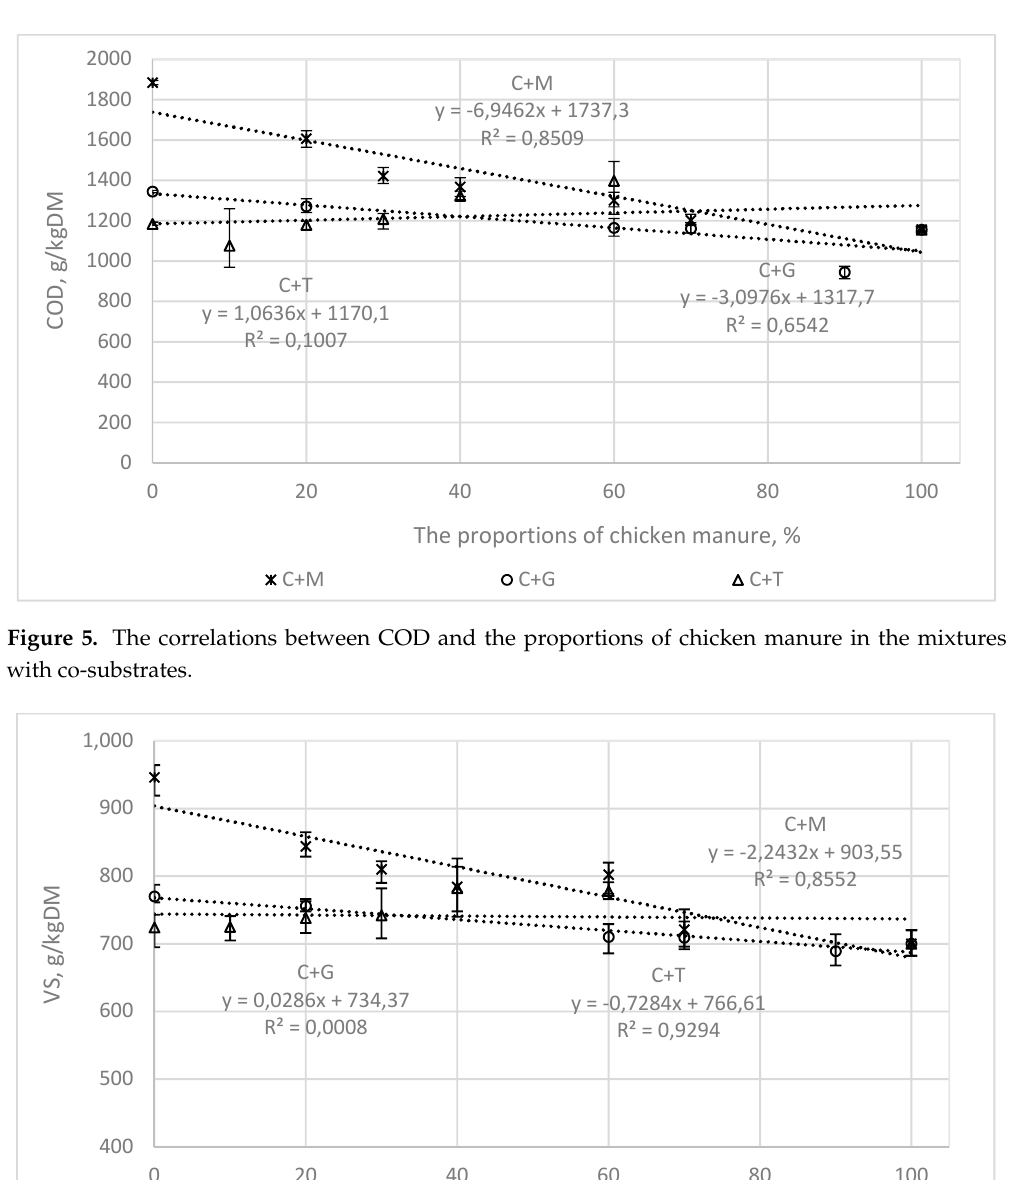
Figure 4. The correlations between AT4 and the proportions of chicken manure in the mixtures with co-substrates .